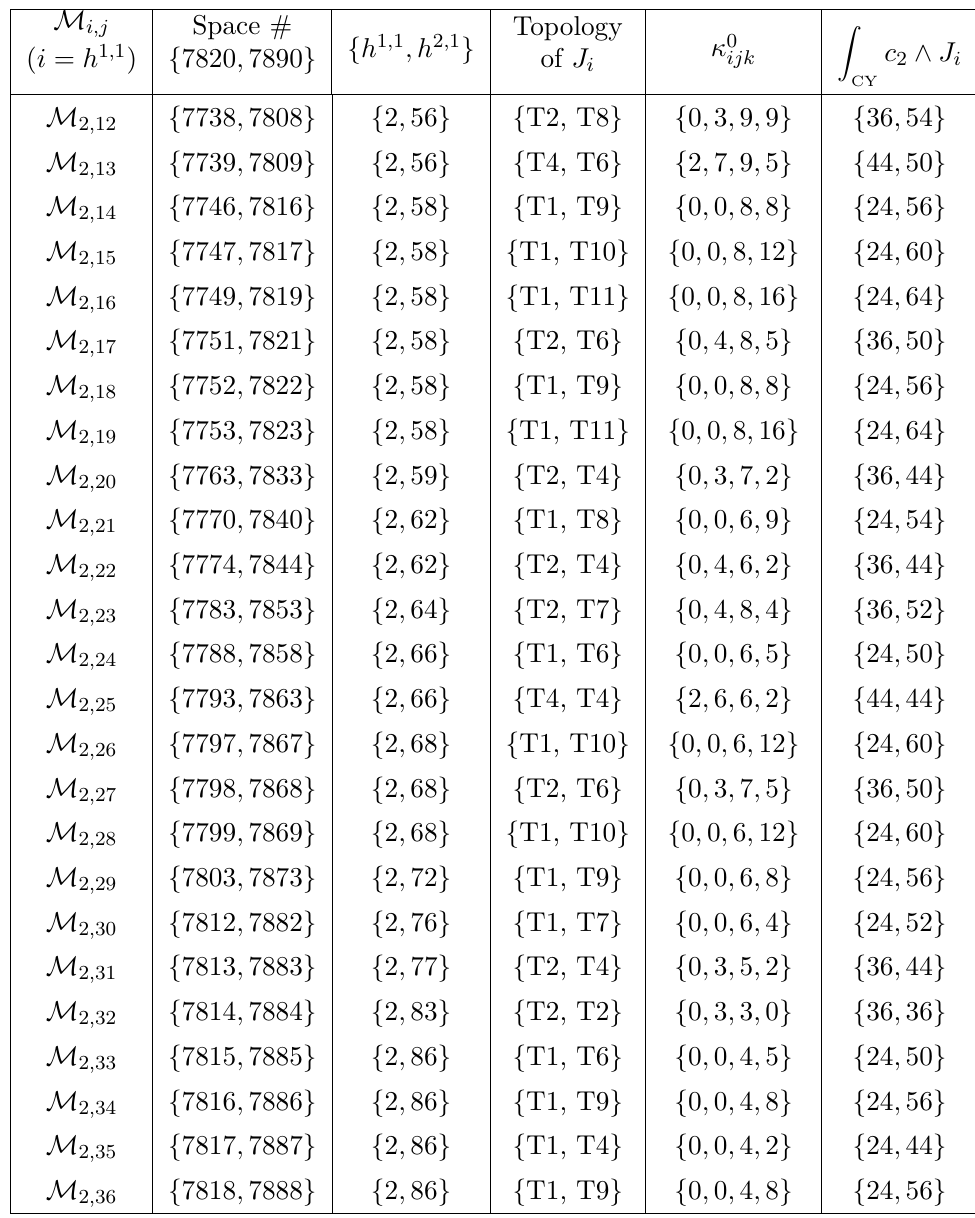
Table 7. Topological data for favorable pCICYs with h 1 , 1 = 2 taken from [33]. The first number of pCICY in the second column is the corresponding number in the list of only favorable pCICY, while the second number is the number of the pCICY following [26]. The classical